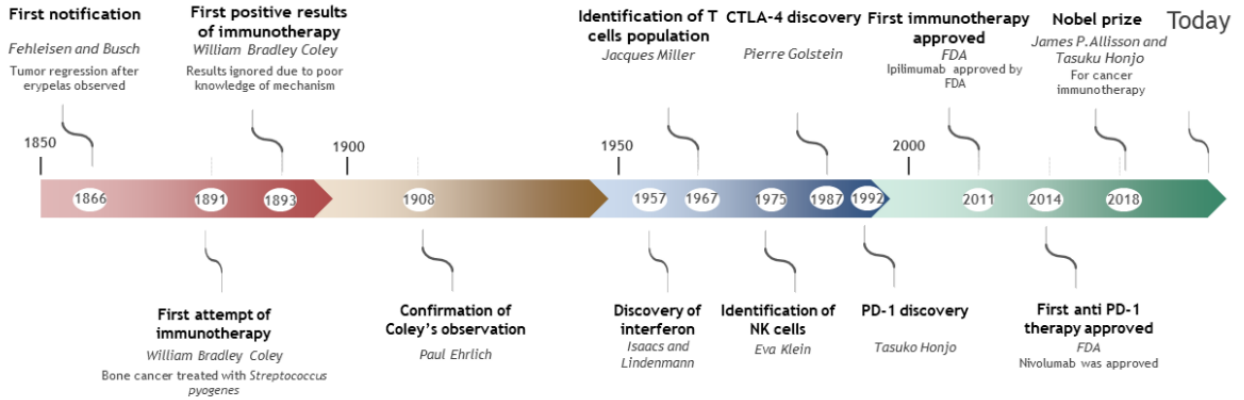
Figure 1. Development of immunotherapy.